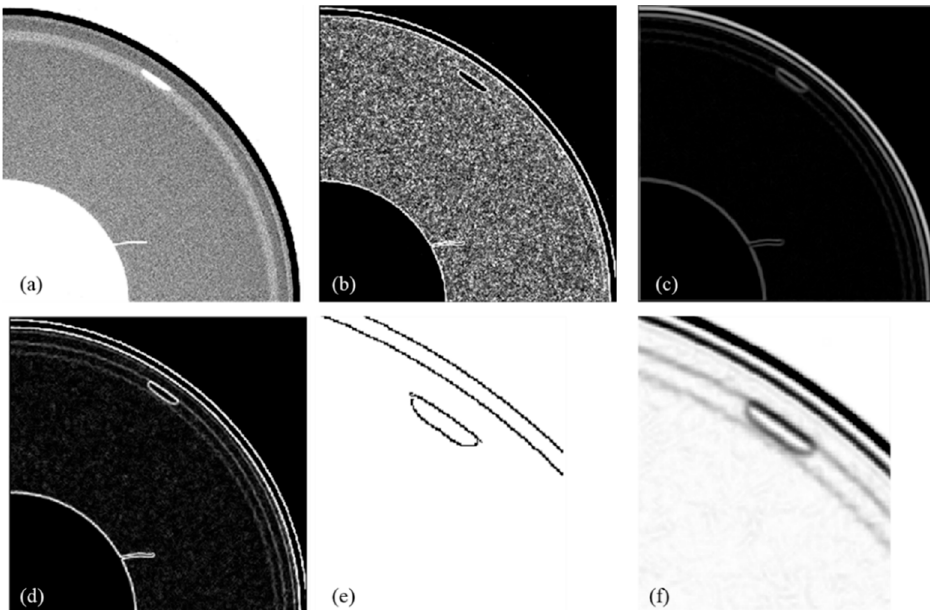
Figure 1. Quarter grain CT images: ( a ) Original images; ( b ) Gradient magnitude images of the originals; ( c ) Gaussian filtered gradient magnitude images; ( d ) Bilateral filtered gradient magnitude images; ( e ) The edge detection images by the wavelet mode maximum; ( f ) The edge detection images by the modified morphological method.